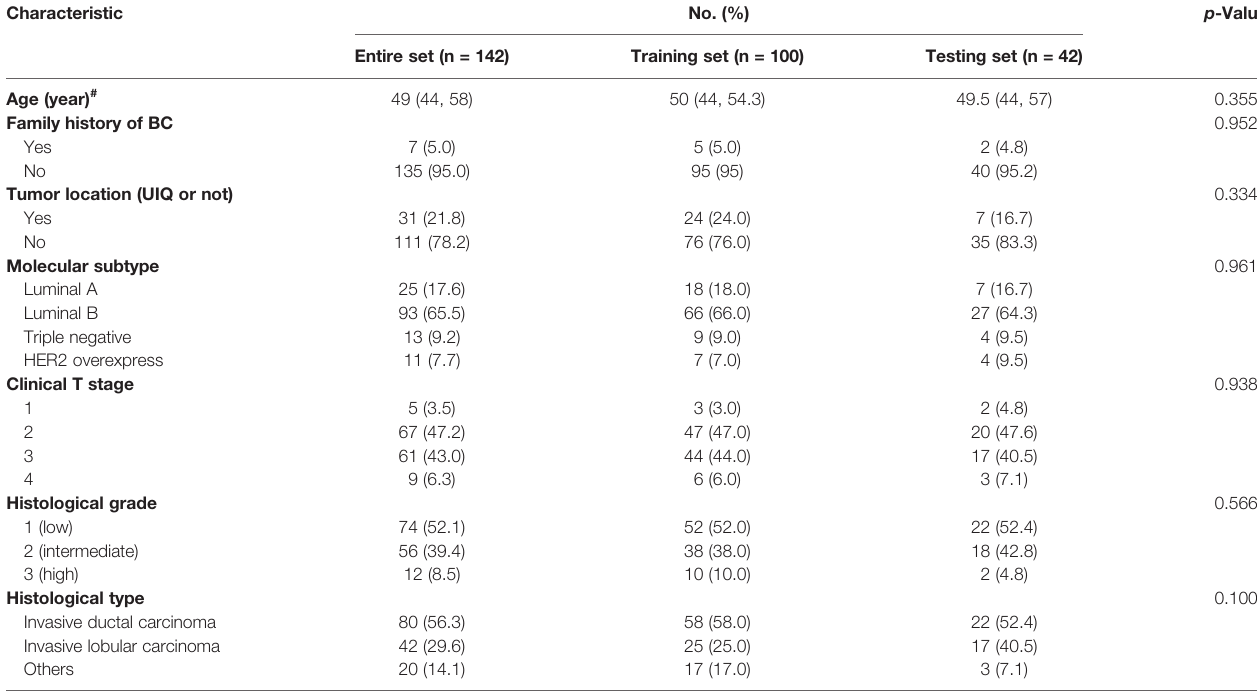
TABLE 1 | Clinicopathological characteristics of patients.